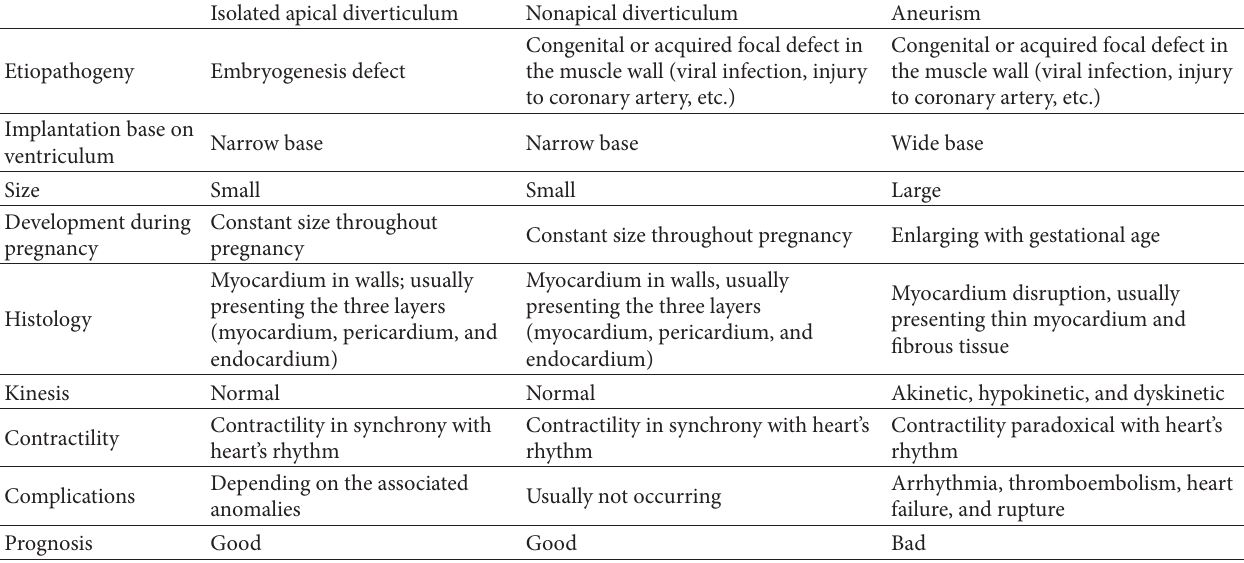
Table 1: Differential diagnosis of the different types of diverticulum and